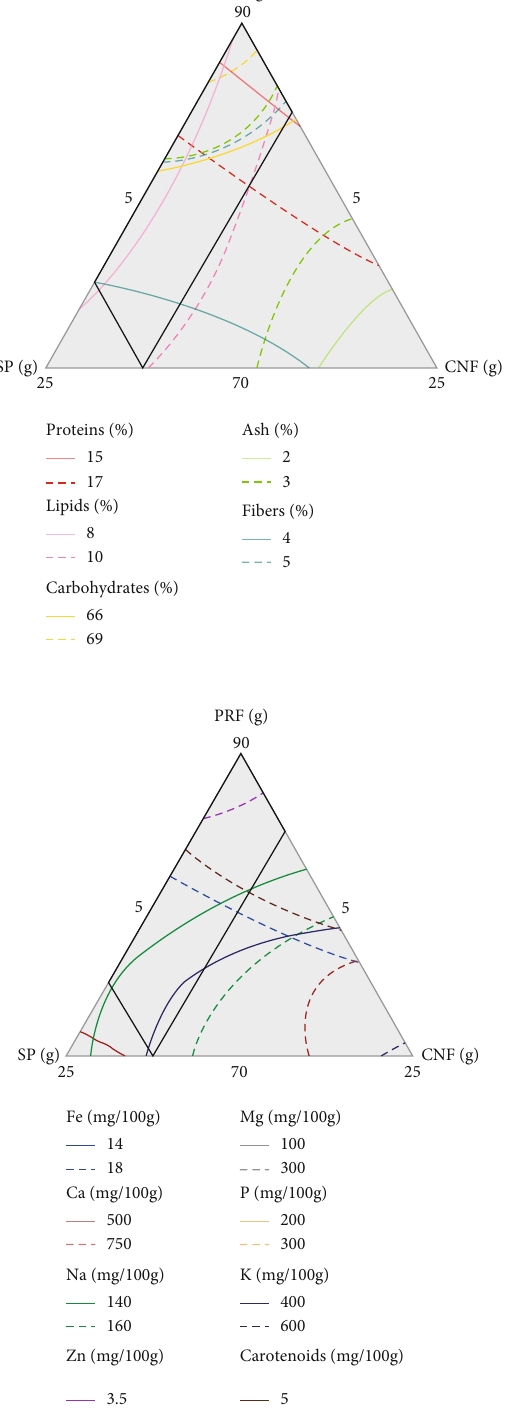
Table 4: Optimal composition of the formulated weaning fl our.